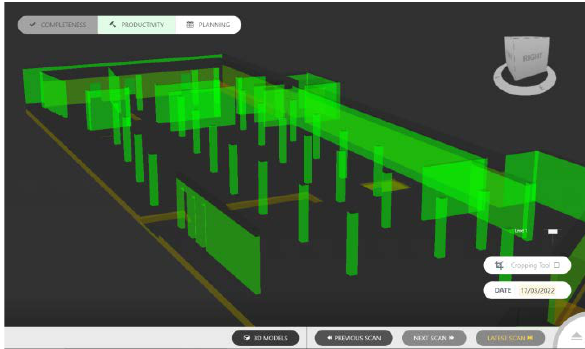
Figure 9. Construction progress showed in Sitemotion as of 31/10/2021.